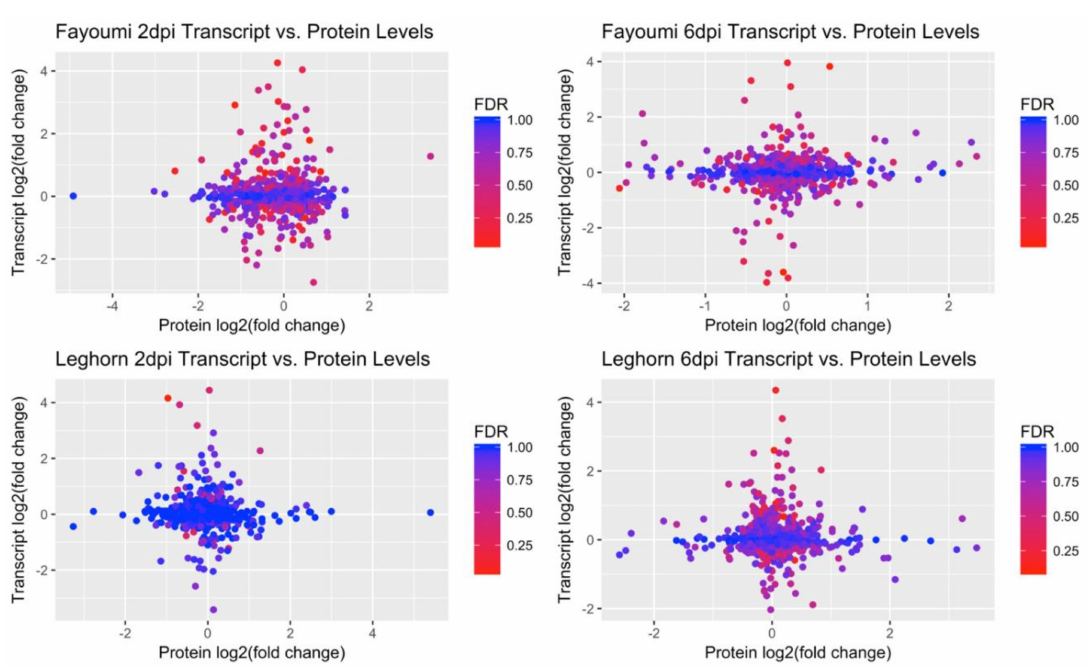
Figure 3. Correlation between the log 2 (fold change) in gene expression and the log 2 (fold change) in protein abundance between treated and non-treated birds at each timepoint. Intensity of each point represents the q-score of the